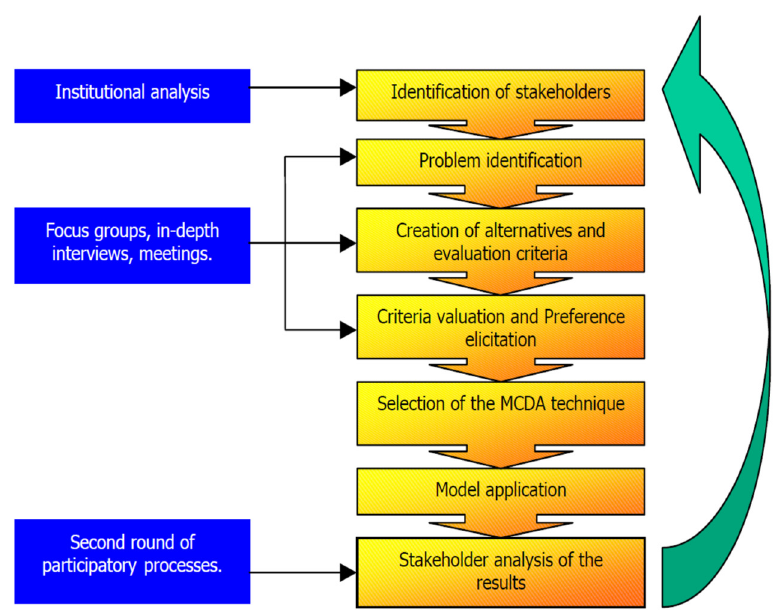
Figure 14. Structure of the model Multi-Critical Social Assessment (SMCE) [4].